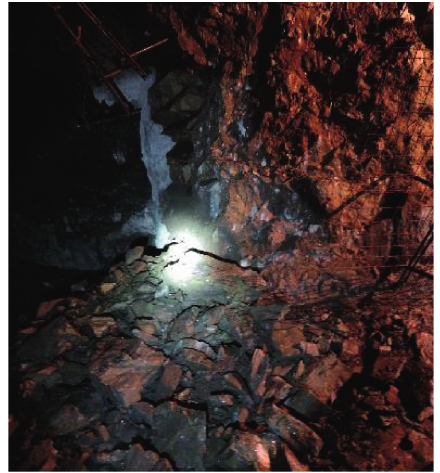
Figure 4: Intense rock burst in Ashele Copper